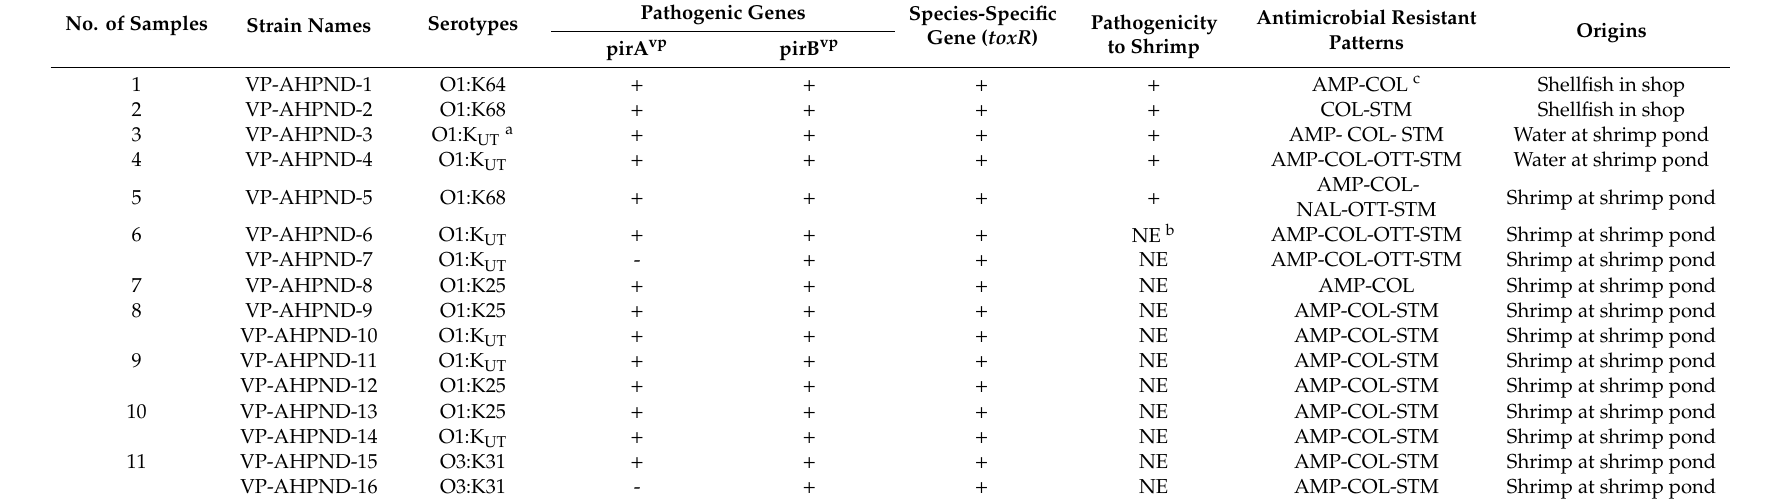
Table 2. Characterization of acute hepatopancreatic necrosis disease (AHPND) V. parahaemolyticus isolated in the Mekong